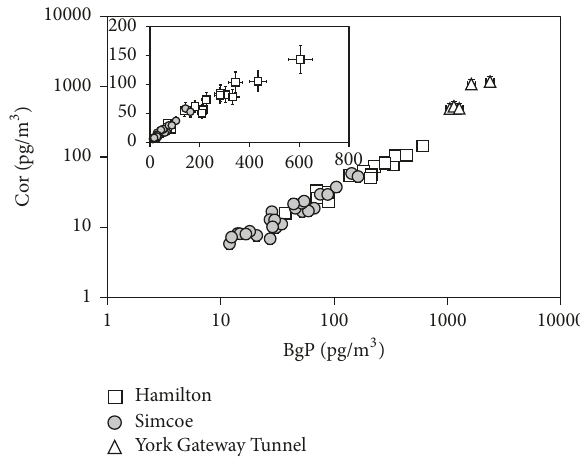
Figure 2: Scatter plot of coronene (Cor) concentration versus benzo[ghi]perylene (BgP) concentration. Plots shown are in log-log scale and the inset shown is in expanded linear scale. The slopes of the linear regressions for Hamilton, Simcoe, and YGT are 0.27 ± 0.01 ( 𝑟 2 = 0.914), 0.37 ± 0.01 ( 𝑟 2 = 0.933), and 0.51 ± 0.04 ( 𝑟 2 = 0.802), respectively. Error bars shown are standard errors estimated from the replicate